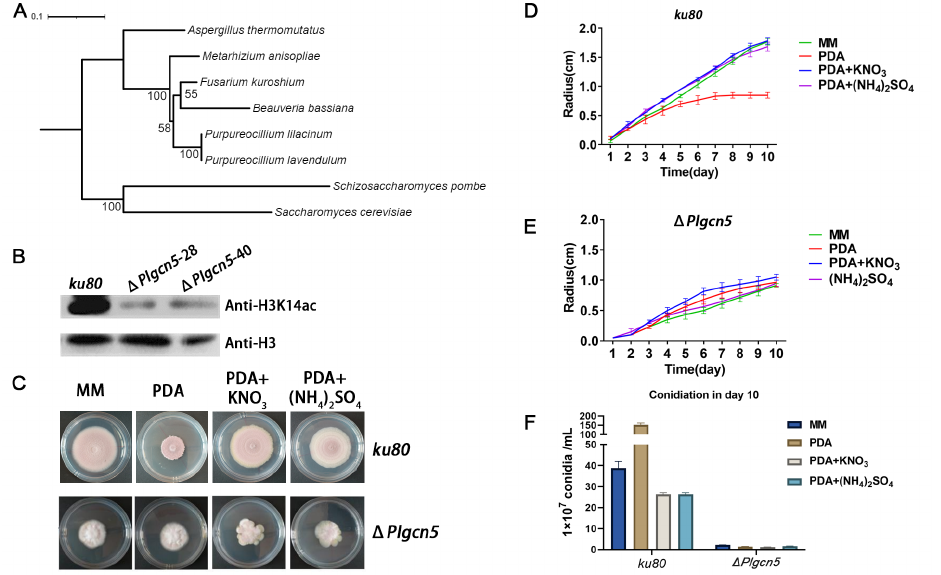
Figure 3. The deletion of histone acetyltransferase Plgcn5 attenuates H3K14 modification and affects the growth of P. lavendulum. ( A ) Phylogenetic analysis of PlGCN5 protein sequences of P. lavendulum and other fungi. ( B ) Western blot validation of Plgcn5 knockout strains using the H3K14ac antibody. ( C ) Comparison of Colony Morphology of the Plgcn 5 knockout strain and the ku80 Strain on four media. ( D , E ) Growth comparison of the Plgcn5 knockout strain and the ku80 strain on four media. ( F ) Conidium comparison of the Plgcn5 knockout strain and the ku80 strain on four media.